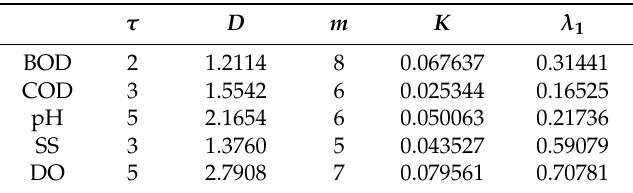
largest Lyapunov exponent λ 1 of the BOD, COD, pH, SS, DO.